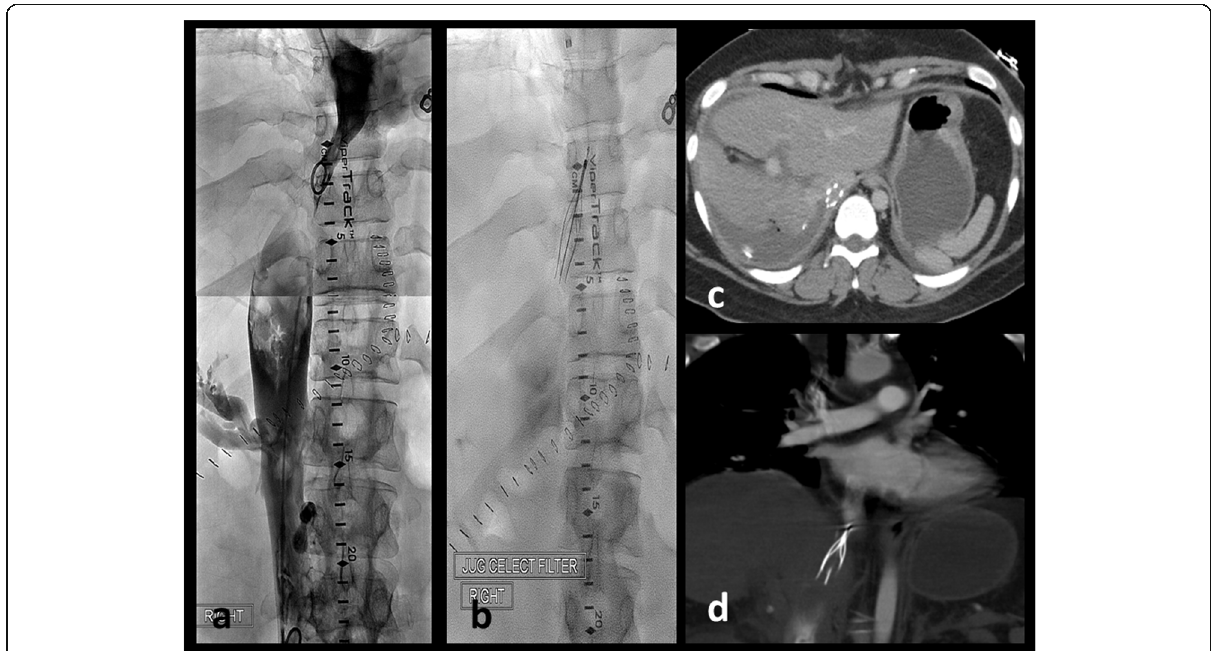
Fig. 2 Two days following right hepatic resection, the patient developed deep vein thrombosis. a . Venogram demonstrates large clots in the suprarenal IVC and narrowing of the superior aspect of the IVC above the hepatic vein inflow. b Suprarenal IVC filter was placed superior to the thrombus. c . and d . Subsequent contrast enhanced axial CT images of the abdomen shows the liver remnant shifted towards the right into the space vacated by the right hepatic lobe. IVC was severely narrowed at the point above the hepatic vein inflow associated with thrombus in